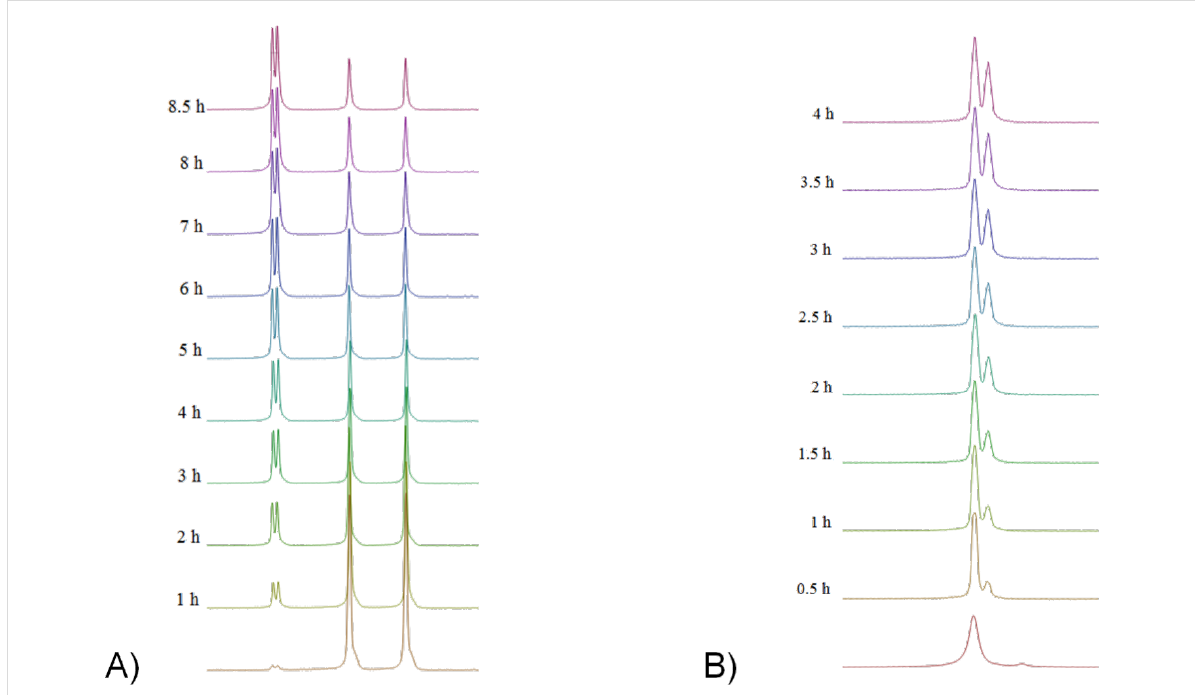
Figure 4: HT-NMR (300 MHz, DMSO- d 6 ) spectra of A) ( syn )- 7 . B) ( syn )- 10 . Only the upfield (ca. 3.4–4 ppm) region of the spectrum is shown. In the figure are shown quantitative changes for signals from the methoxy group. Full spectra for individual atropisomers are shown in Supporting Informa- tion File 1.